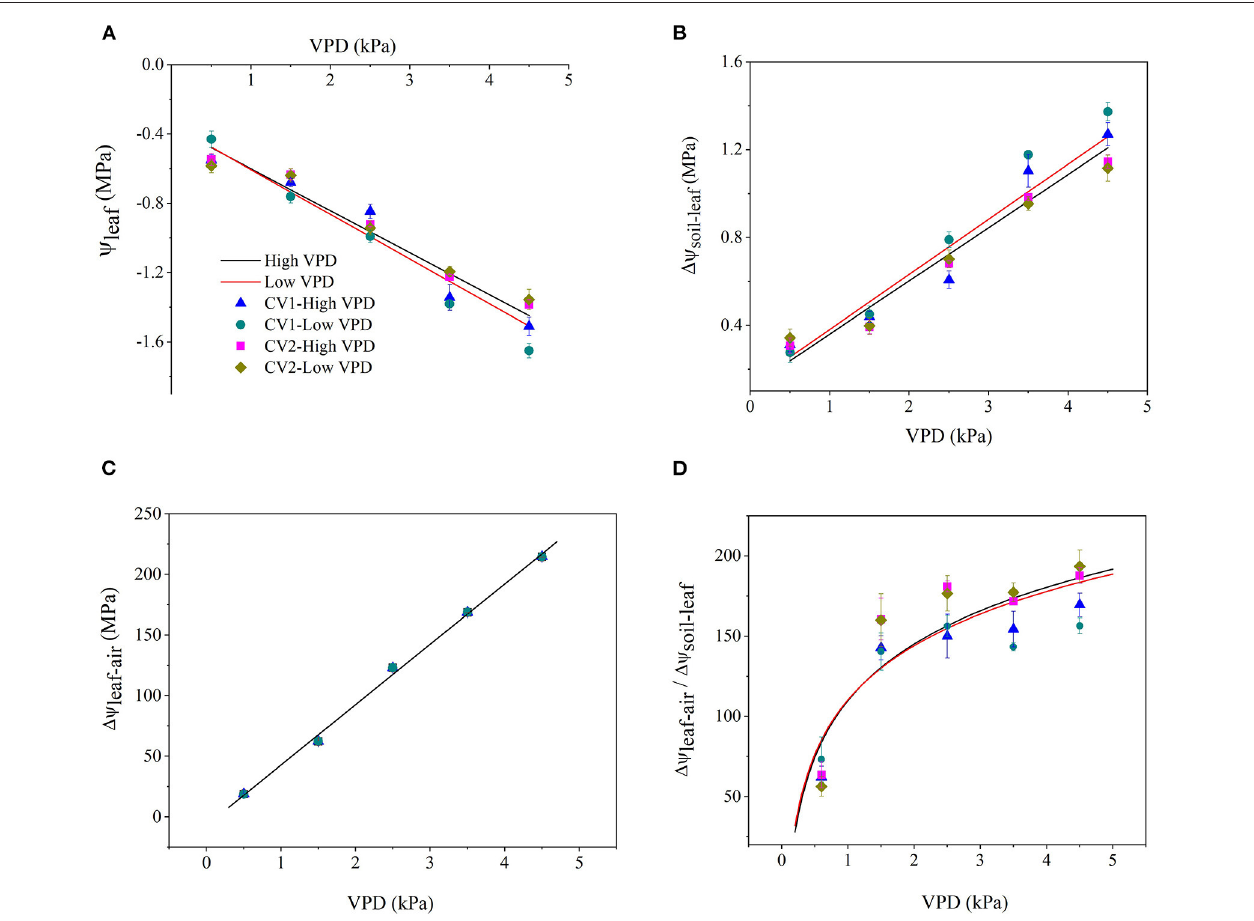
FIGURE 1 | Effect of the vapour pressure deficit (VPD) on the spatial distribution of the water potential and driving force ( 19 ) between two spatial positions. Values are the mean ± SE ( n = 4 ∼ 6 replicates). The regression lines shown are: (A) HVPD, 9 leaf = − 0.242 VPD − 0.358, R 2 = 0.92; LVPD, 9 leaf = − 0.258 VPD − 0.347, R 2 = 0.93. (B) HVPD, 19 soil − leaf = 0.242 VPD + 0.118, R 2 = 0.94; LVPD, 19 soil − leaf = 0.251 VPD + 0.13, R 2 = 0.93. (C) HVPD, 19 leaf − air = 49.8 VPD − 6.86, R 2 = 0.98; LVPD, 19 leaf − air = 49.8 VPD − 6.86, R 2 = 0.98. (D) HVPD, 19 leaf − air / 19 soil − leaf = 50.82 ln (VPD) + 109.95, R 2 = 0.85; LVPD, 19 leaf − air / 19 soil − leaf = 48.63 ln (VPD) + 110.41, R 2 =